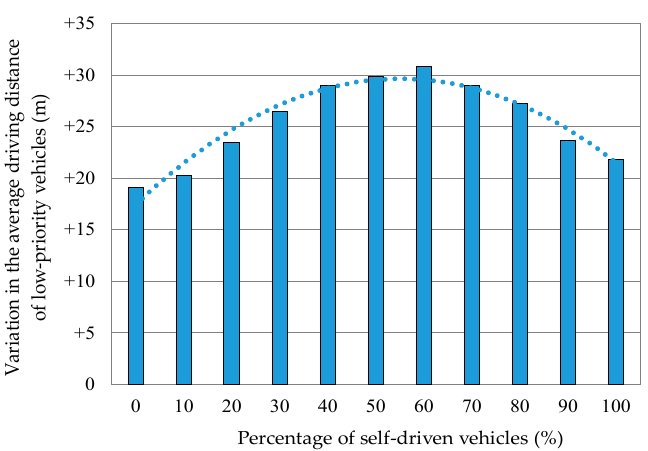
Figure 17. Variation in the average driving distance of low-priority vehicles when the percentage of self-driven vehicles was varied. The average driving distance was the average for all the vehicles that came in.